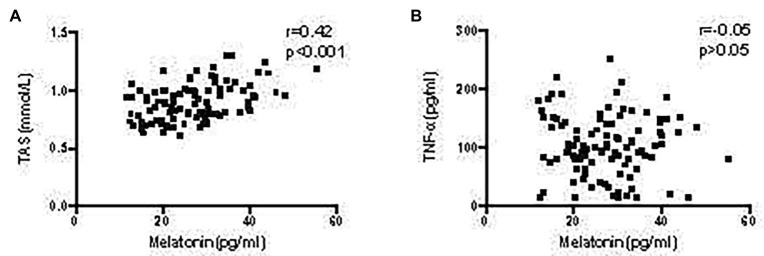
Correlation of melatonin levels with TAS and TNF-α levels in patients with AAA. (A) Correlation between melatonin and TAS levels. (B) Correlation between melatonin and TNF-α levels.